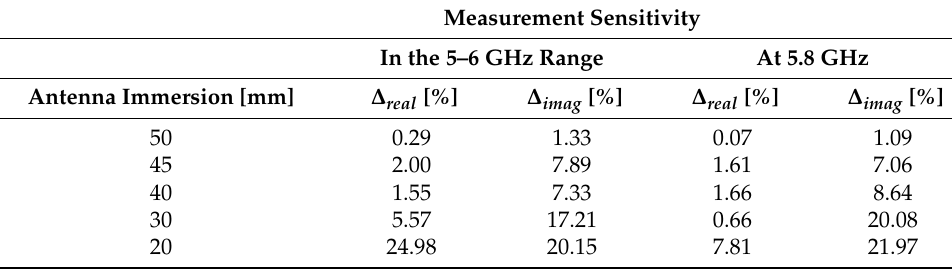
Figure 20. S&S de-embedding of liver simulated with different antenna immersions: ( a ) real and ( b ) imaginary part of complex permittivity. Table 6. Average sensitivity in the 5–6 GHz range and at 5.8 GHz for different immersion lengths.